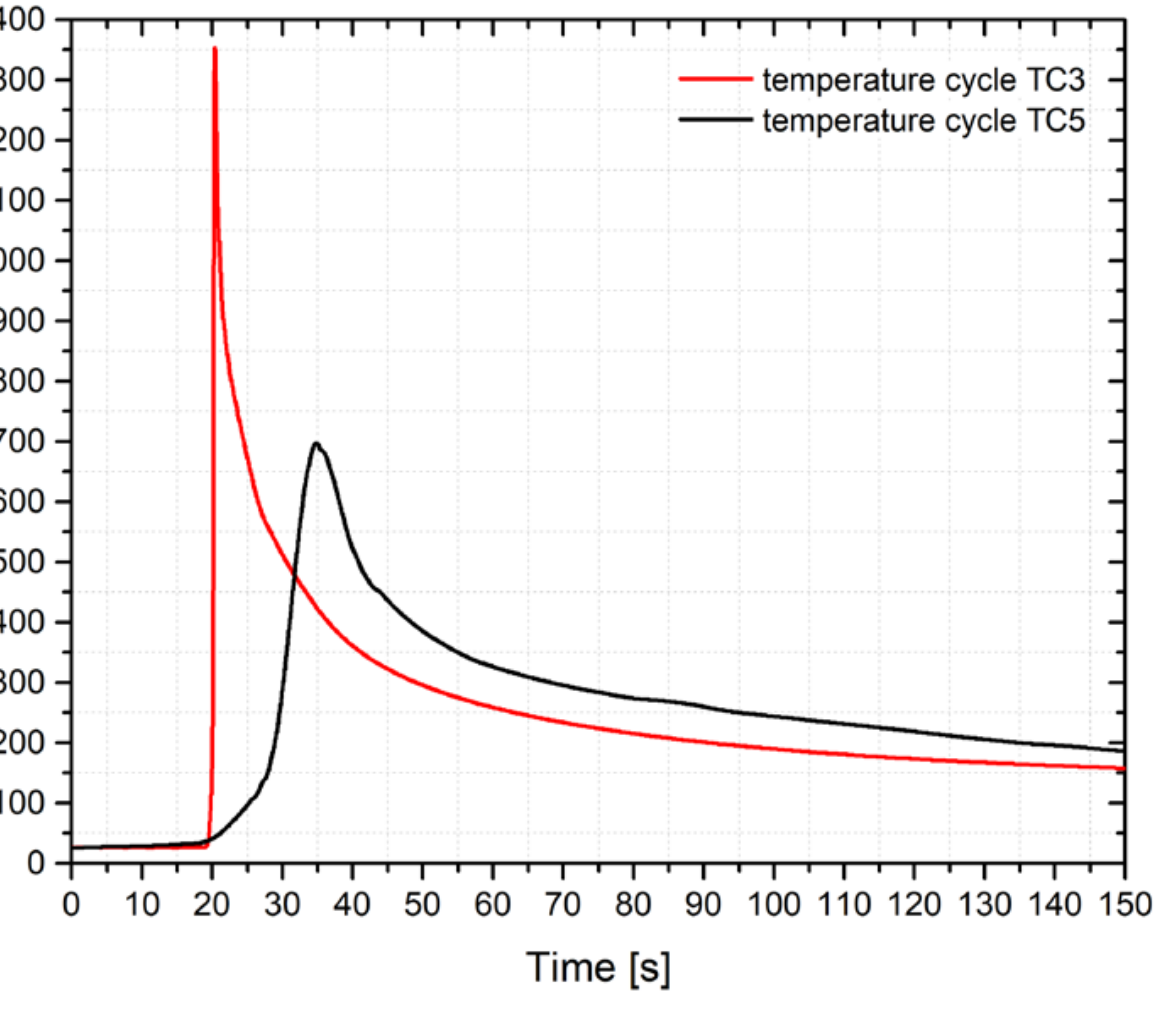
Figure 10. Temperature cycles measured by thermocouples TC3 and TC5.